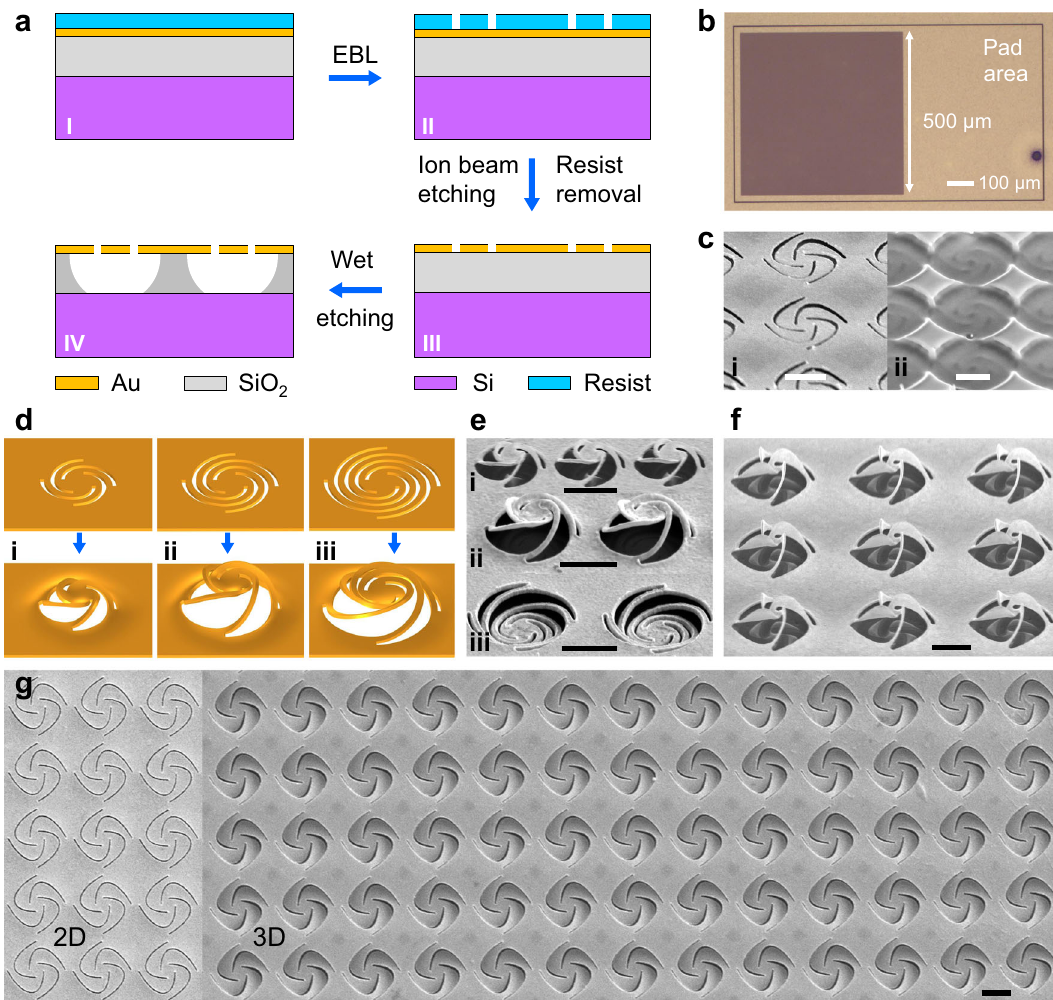
Fig. 2 Sample fabrications. a Flow chart of the fabrication process on an Au/SiO 2 /Si chip. b Camera image of a pinwheel array with area of 500 × 500 μ m 2 before wet etching. c SEM images of i pinwheels after wet etching and ii the below SiO 2 supporters after removing the top gold with FIB (Supplementary Fig. 2g). d Schematic of 2D and deformed 3D spirals in simulations. Image sizes: 2.5 × 2.5 μ m 2 . The 2D spirals consist of four arcs with angles of (i) 180°, (ii) 270°, and (iii) 360°, respectively, which are deformed into 3D by exerting upward stresses of 3, 3, and 1 GPa in simulations. e , f SEM images of three